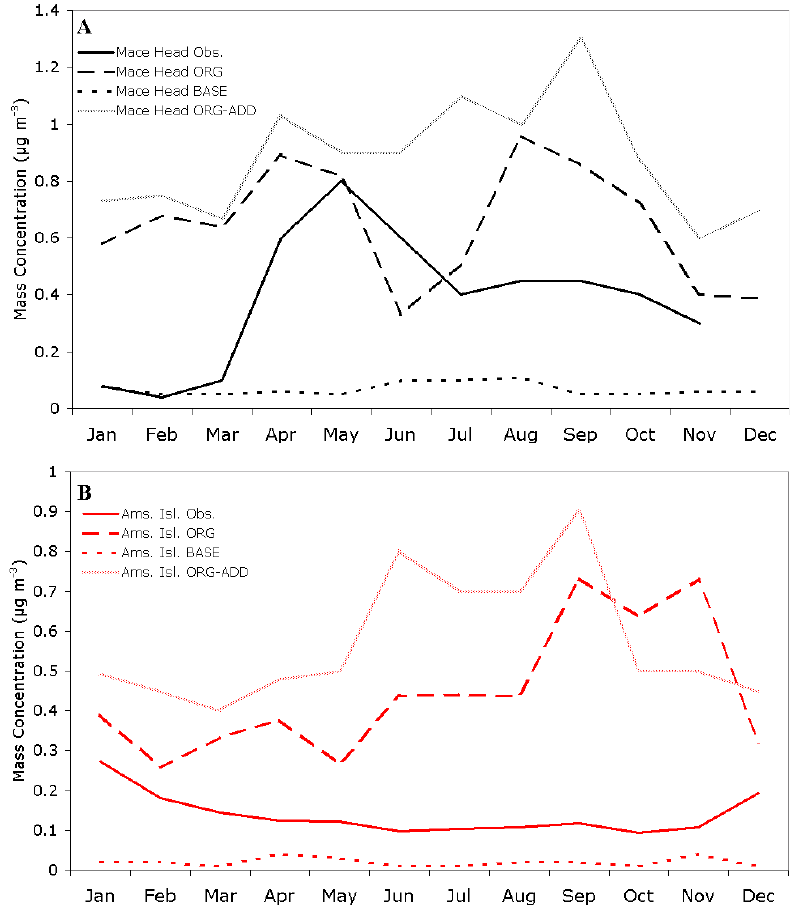
Fig. 2. Model and measurement comparison of total organic aerosol concentrations at two locations. Solid lines represent observations at Mace Head (black, panel A ) and Amsterdam Island (red, panel B ), and long dashed lines represent modelled values with marine organic enhancement at Mace Head (black) and Amsterdam Island (red). Short dashed lines represent model predictions at Mace Head (black) and Amsterdam Island (red) for simulations without the marine organic source function. The grey line in panel (A) and lighter shade of red in panel (B) represent model values at Mace Head and Amsterdam Island when the replacement assumption is not used (“ORG-ADD” simulation). Model values are reported for total organic aerosol, both hydrophobic and hydrophilic. Measured data is in the form of